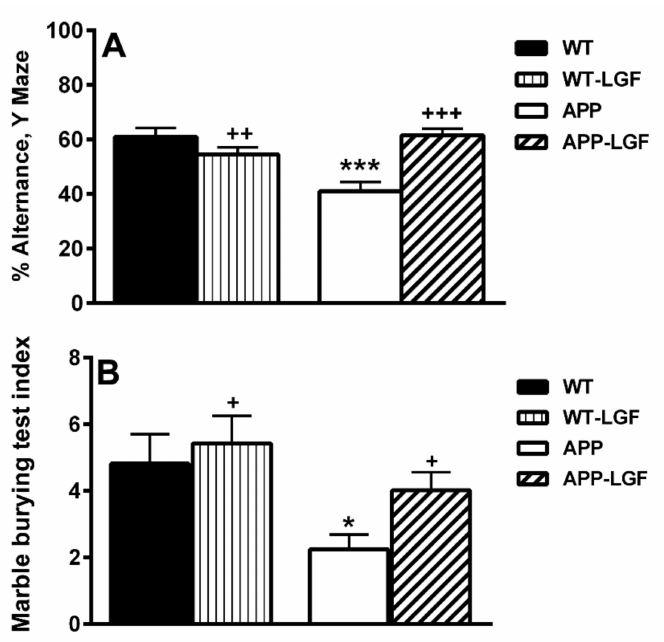
Figure 1. Liver growth factor (LGF) improves cognitive behavior in APPswe mice. Panel ( A ) shows how the alternance index in the Y-maze is significantly reduced in APP mice, and how LGF treatment recovers this important marker of working memory. As shown in panel ( B ), the marble burying test index is significantly reduced in APP mice, and LGF recovers this potential index of hippocampal and cortical a ff ection. Results represent the mean ± SEM of 11 to 16 independent mice. The statistical analysis was performed by one-way ANOVA followed by Newman–Keuls test. * p ≤ 0.05, *** p ≤ 0.001 vs. wild type (WT). + p ≤ 0.01, ++ p ≤ 0.01, +++ p ≤ 0.001 vs. APP